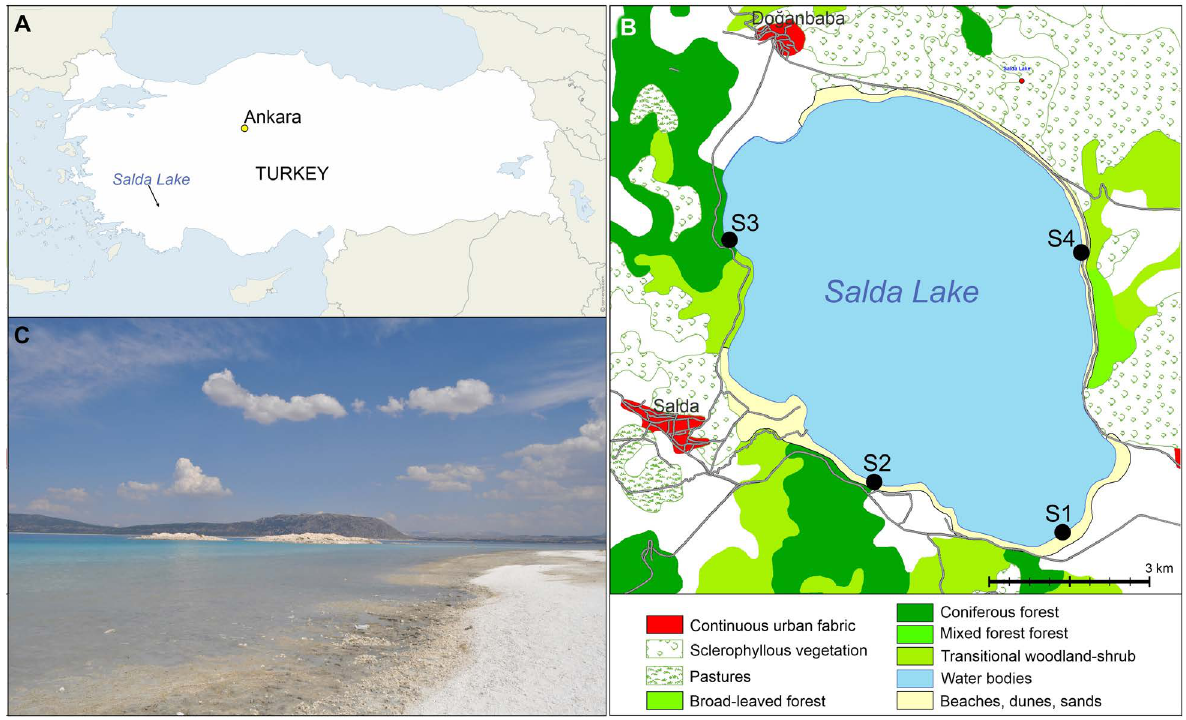
Figure 1. Study area. A . Location of Lake Salda in Turkey. B . Location of the sampling stations (S1–S4) around the lake. C . General view of the lake (photo by Cüneyt Nadir